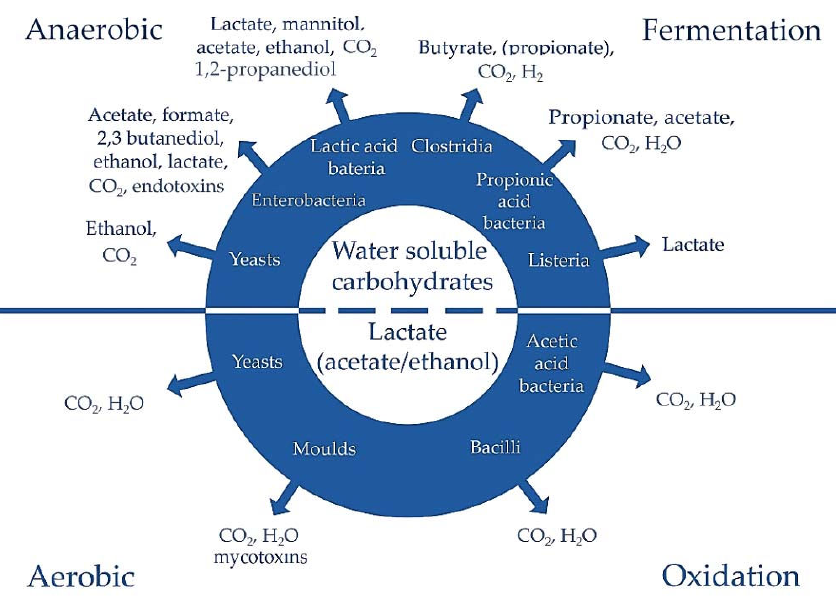
Figure 1. A main group of microorganisms involved in the fermentation process (modified on the basis of